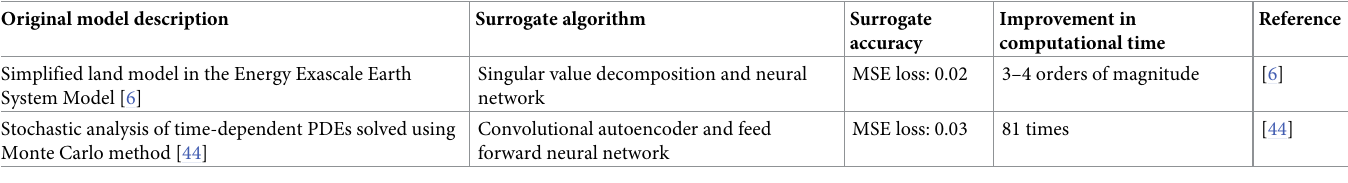
Table 2. Summary of the performance and methodologies of the ML surrogate models that describe engineering processes with methodologies that can be extended to surrogates of biological models. Original model